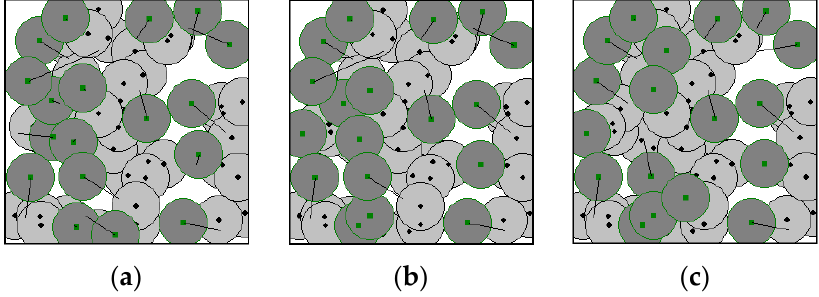
Figure 5. ( a ) Result of the proposed CEADE algorithm; ( b ) refinement result of Algorithm 1 step 1;